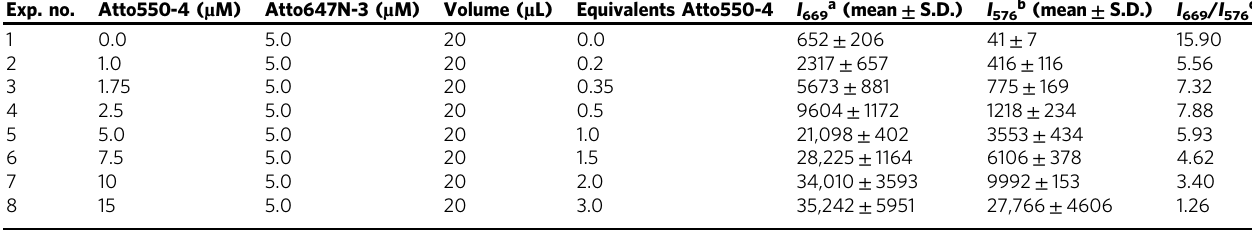
Table 1 Atto-labeled motifs 3 and 4 mixed in different ratios to form HyApNc nanoconstructs Exp. no. Atto550-4 ( µ M) Atto647N-3 ( µ M) Volume ( µ L) Equivalents Atto550-4 I 669 a (mean ± S.D.) I 576 b (mean ± S.D.) I 669 / I 576